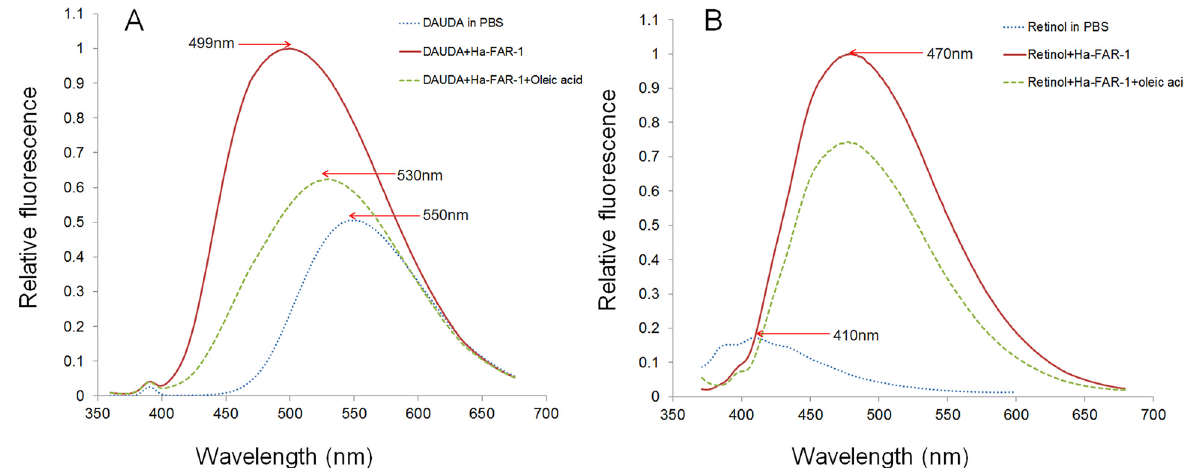
Fig 7. Competition analysis of oleic acid-displaced DAUDA (A) or retinol (B) from Ha-FAR-1 binding sites. A: The reversed change of fluorescence intensity (excitation at 345 nm) was observed after the addition of oleic acid to the 10 μ M DAUDA +1.5 μ M Ha- FAR-1 complex. The wavelengths of peak emission by DAUDA were changed from 499 nm to 530 nm. B: Fluorescence intensity (excitation at 350 nm) produced a pronounced drop after adding oleic acid to 10 μ M retinol +2.5 μ M Hf-FAR-1